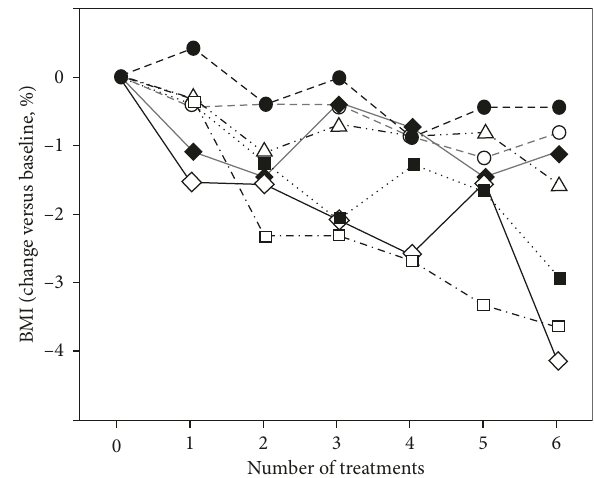
Figure 4: Progressive decline in BMI (expressed as %) in group 2 undergoing six rounds of tissue cryotherapy. Although all in- dividuals responded, the figure illustrates the interindividual variability, in accord with other studies (e.g., [18,